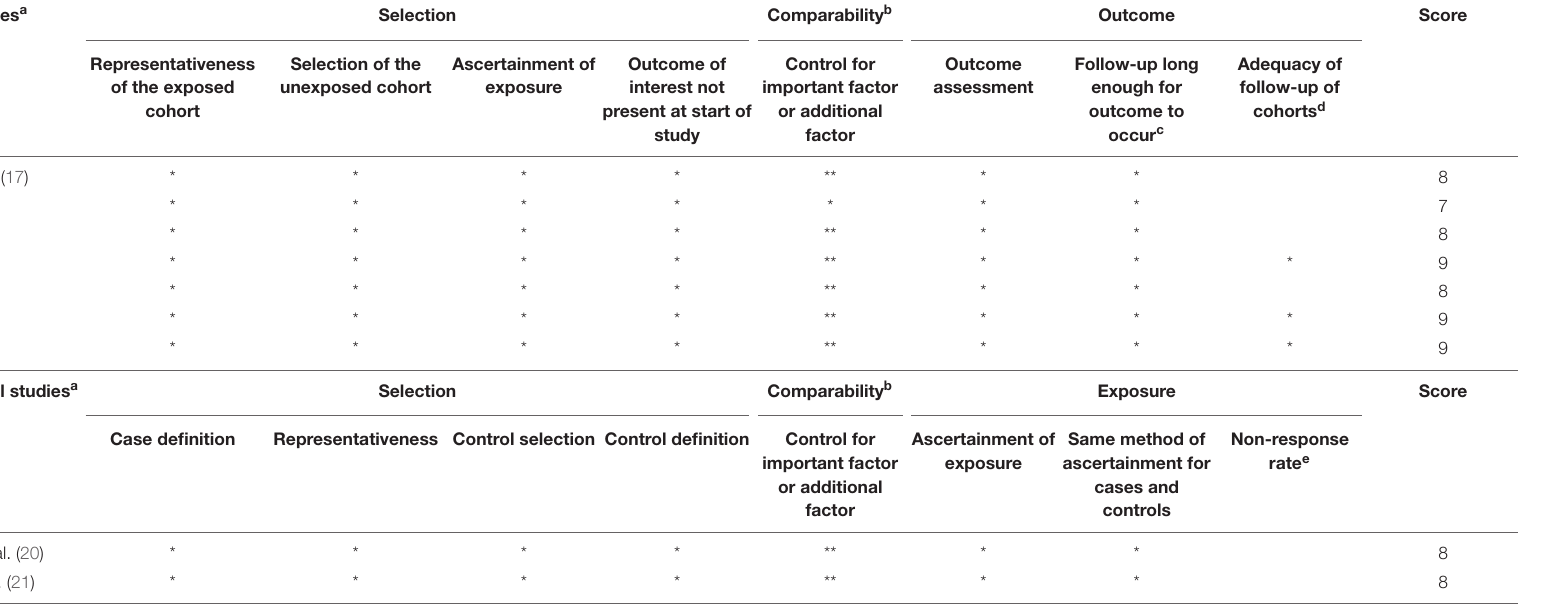
TABLE 2 | Methodological quality of studies included in the meta-analysis. Cohort studies